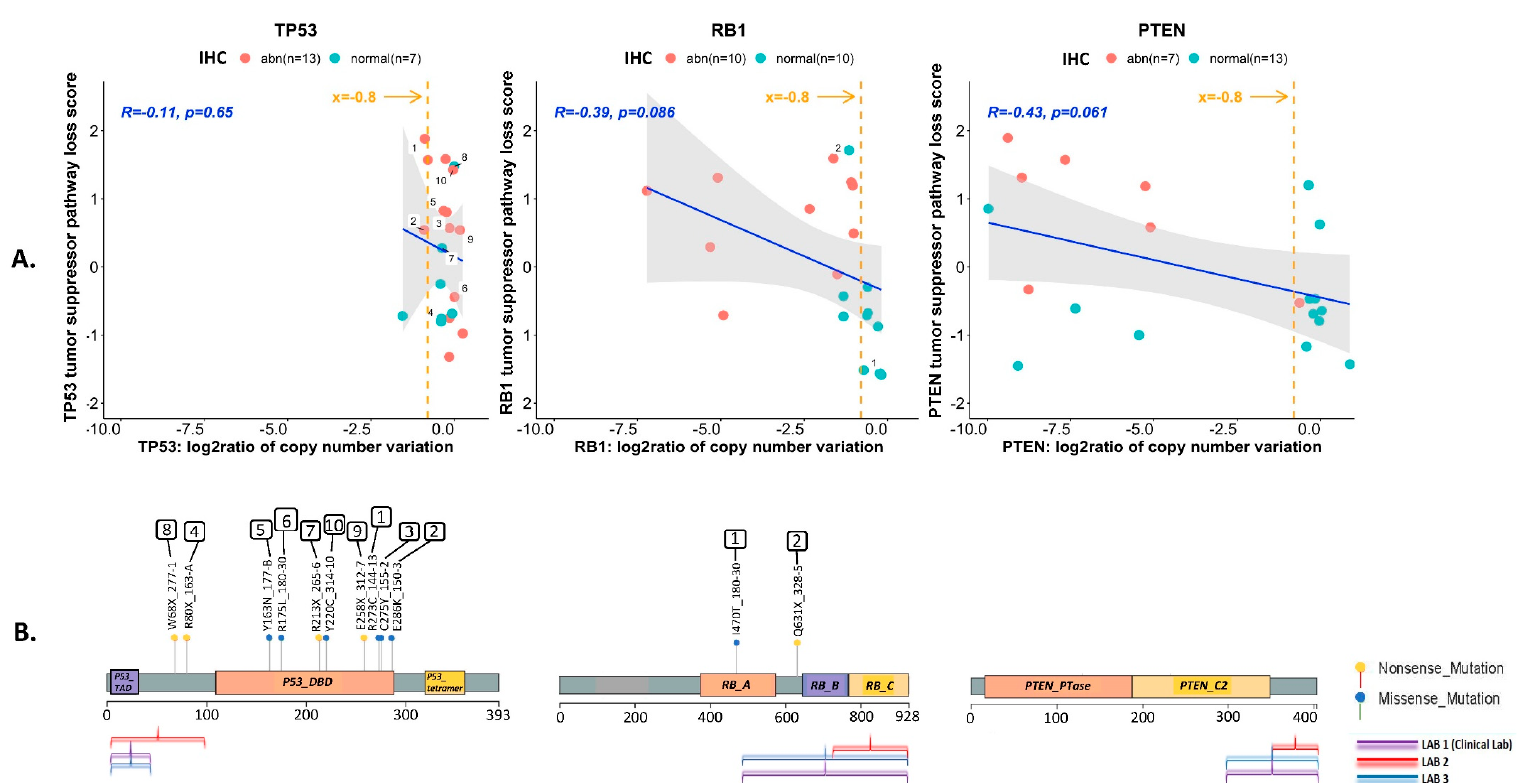
Figure 4. Genotype-to-phenotype correlations for each of the three tumor suppressors (TP53, RB1 and PTEN) using 20 MDA PCa PDX samples. ( A ) Correlations between the log2 ratios of the copy number variations for each of the tumor suppressors (TP53, RB1 and PTEN) identified by T200 analyses, and the transcriptional scores for tumor suppressor pathway loss. The orange line indicates the cutoff used to infer deep deletion (x = − 0.8). The blue line is the ordinary least squares regression fit. The grey shaded region around each line is a 95% confidence interval set for the fit. The correlation (R) and significance of correlation ( p -value for testing if correlation is 0) are included in each plot in blue text. Also shown is the categorization of each sample as normal (green dot) or abnormal (red dot) based on immunohistochemical (IHC) analyses. Samples harboring single nucleotide variations (mutations) are numbered. ( B ) Location of the identified mutations on the primary protein structure of the corresponding TSP, and the epitopes recognized by antibodies used for IHC staining. Nonsense mutations are shown as yellow dots, and missense mutations are shown as green dots. No mutations were identified for PTEN. Key functional domains are highlighted for p53 protein (trans-activation domain ( TAD ), DNA binding domain ( DBD ) and the oligomerization domain ( tetramer )), RB1 protein (small pocket region containing the A ( RB_A ) and B ( RB_B ) domains and the C-terminal domain ( RB_C )), and PTEN protein (phosphatase domain ( PTEN_PTase ) and C2 domain ( PTEN_C2